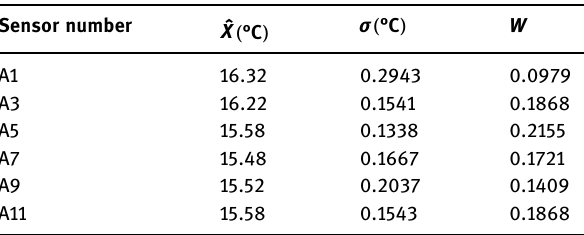
Table 6: Fusion results after improved algorithm processing